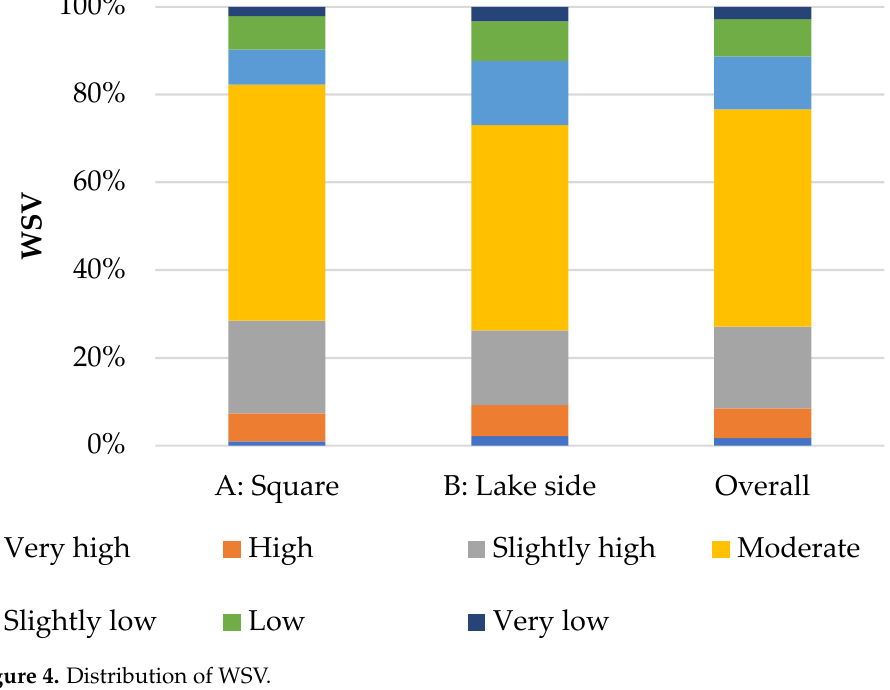
Figure 4. Distribution of WSV.